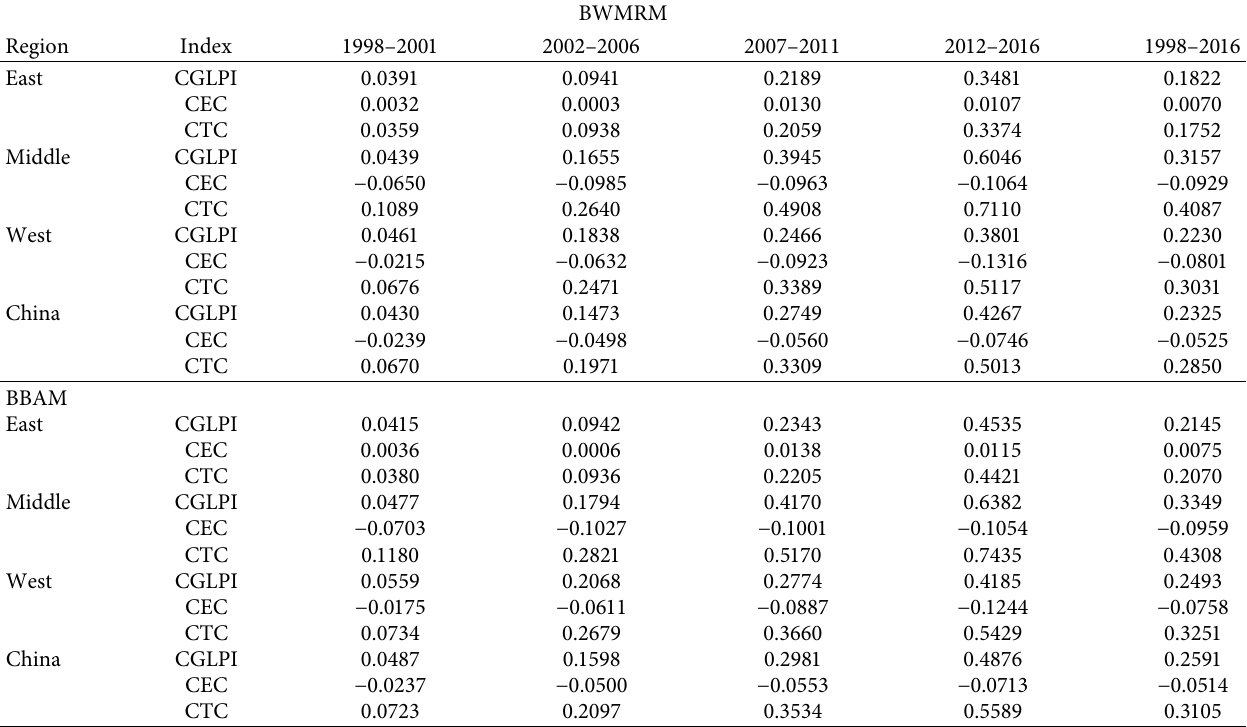
Table 4: The mean of CGLPI and its components in three regions.